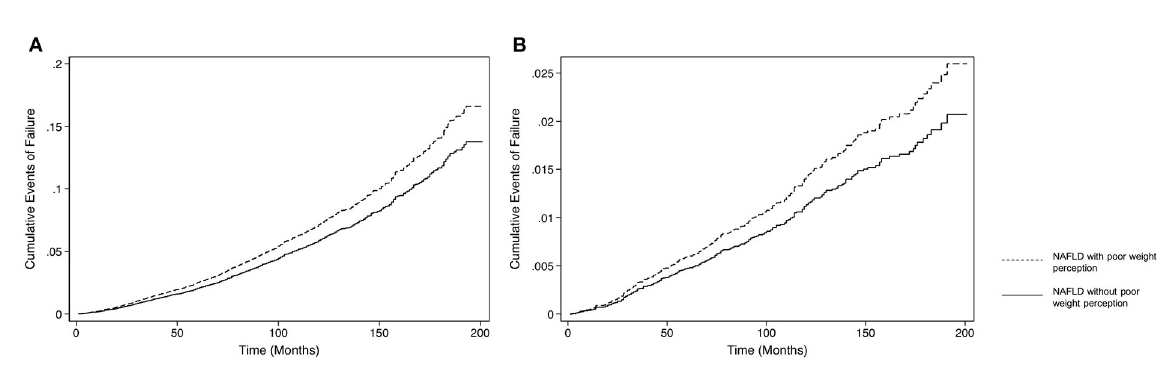
different weight classes (overweight and obese). The